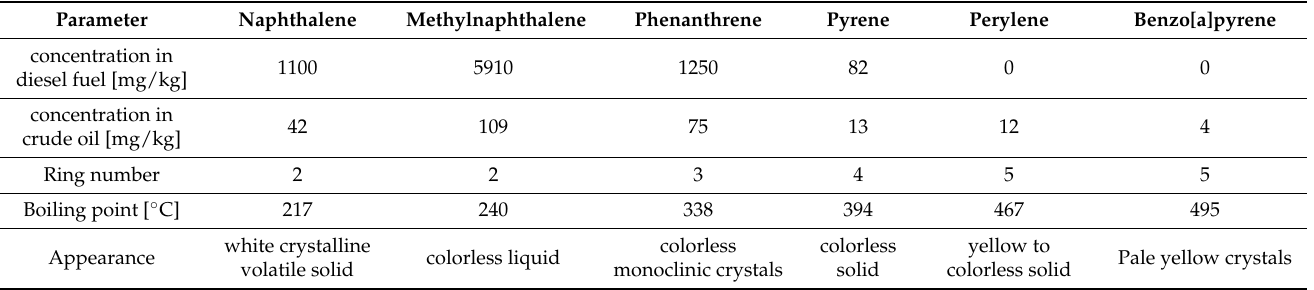
Table 1. Example PAHs concentration in diesel fuel and crude oil and characteristics